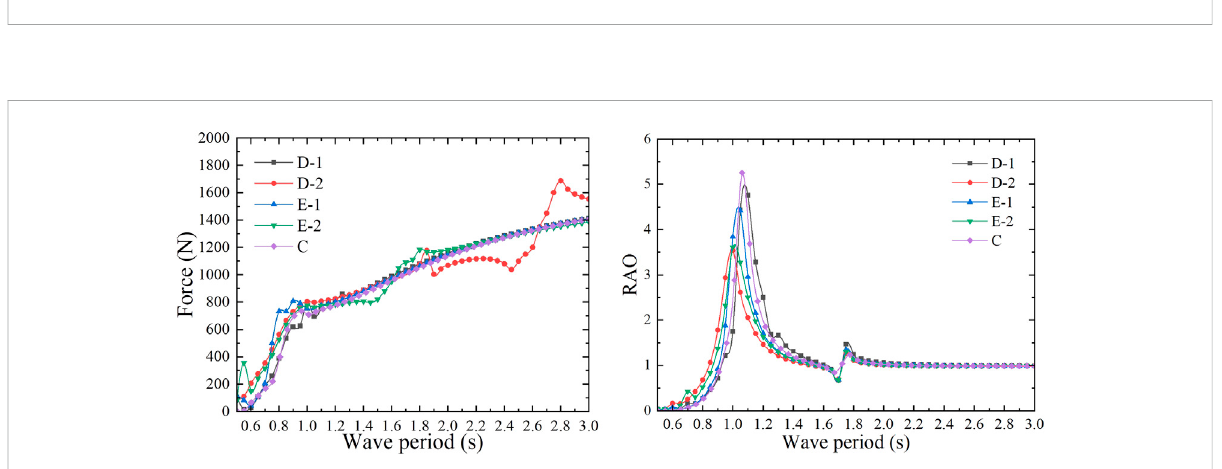
FIGURE 16 Wave excitation force on models with different bottom shapes (left) and their heave RAO (right).